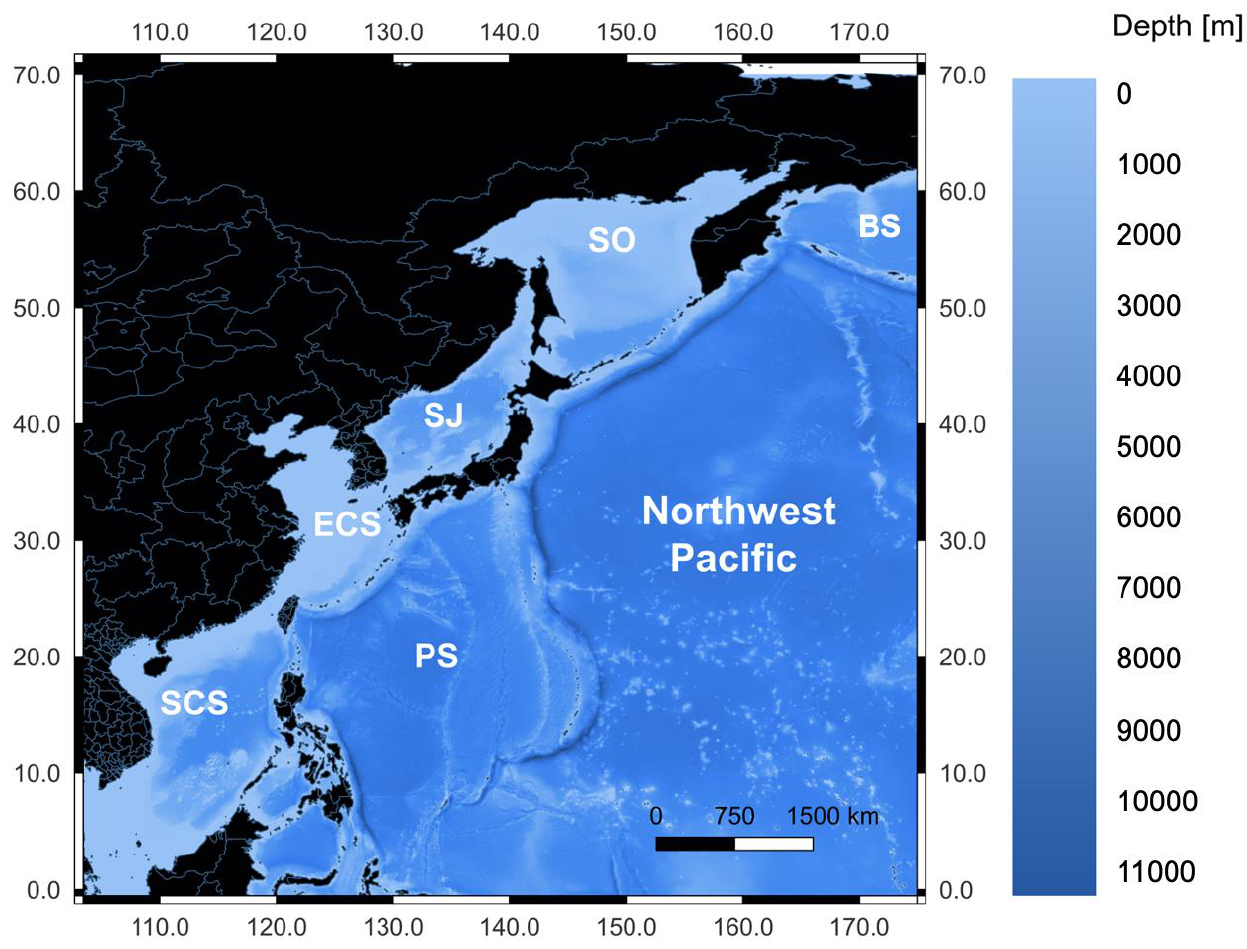
Figure 1. Map of the study region in the Northwest Pacific from latitudes 0–65° and longitudes 100–180°. BS = Bering Sea, SO = Sea of Okhotsk, SJ = Sea of Japan, ECS = East China Sea, SCS = South China Sea, PS = Philippine Sea.